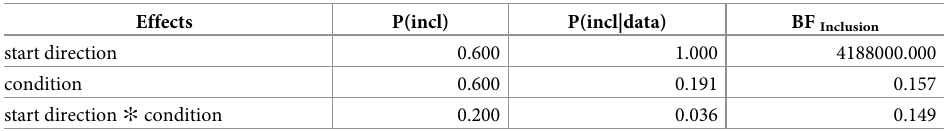
Table 3. Bayesian analysis of